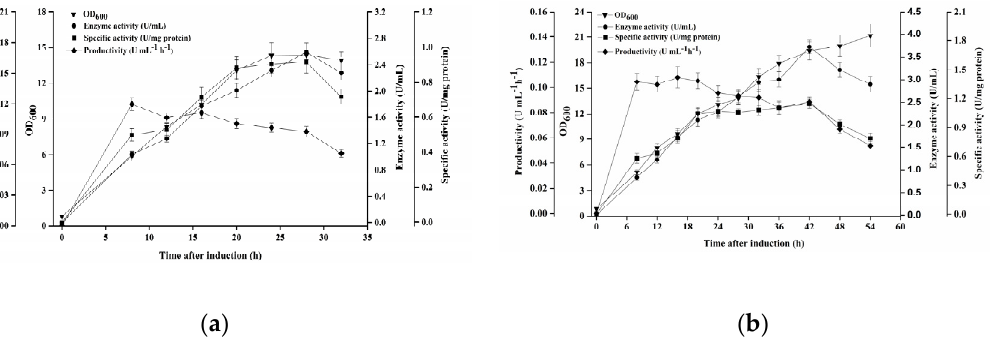
Figure 8. ( a ) Batch fermentation profiles in a shake flask. ( b ) Batch fermentation profiles in a shake flask with nitrogen-source feeding.